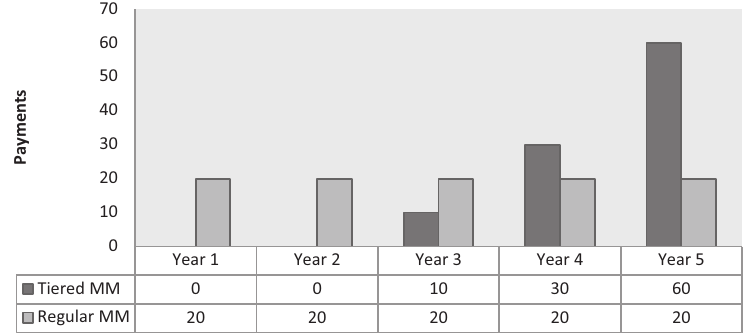
Figure 1. Ordinary vs